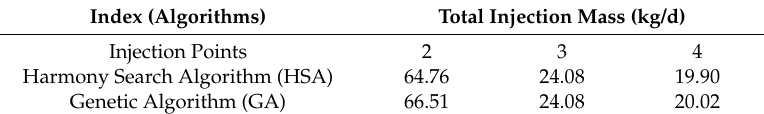
Table 4. Comparison results between HSA and Genetic Algorithm (GA) (P-City, network 1).